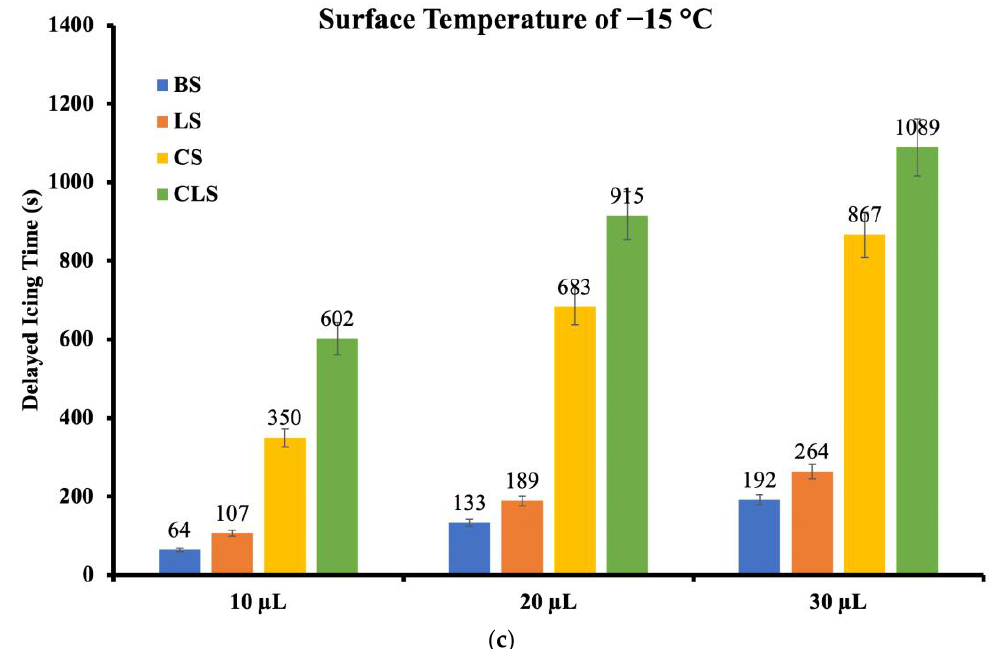
Figure 6. The delayed icing time of different droplet sizes on BS, LS, CS, and CLS at the surface temperatures of ( a ) −5 °C, ( b ) −10 °C, and ( c ) −15 °C.